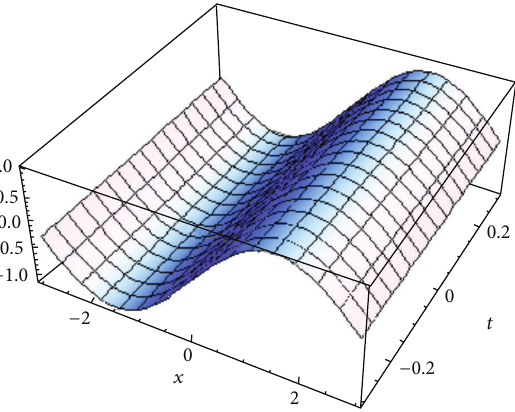
Figure 1: 3D, OHAM solution of 𝛽(𝑥,𝑡) at 𝑡 = 0.1 .